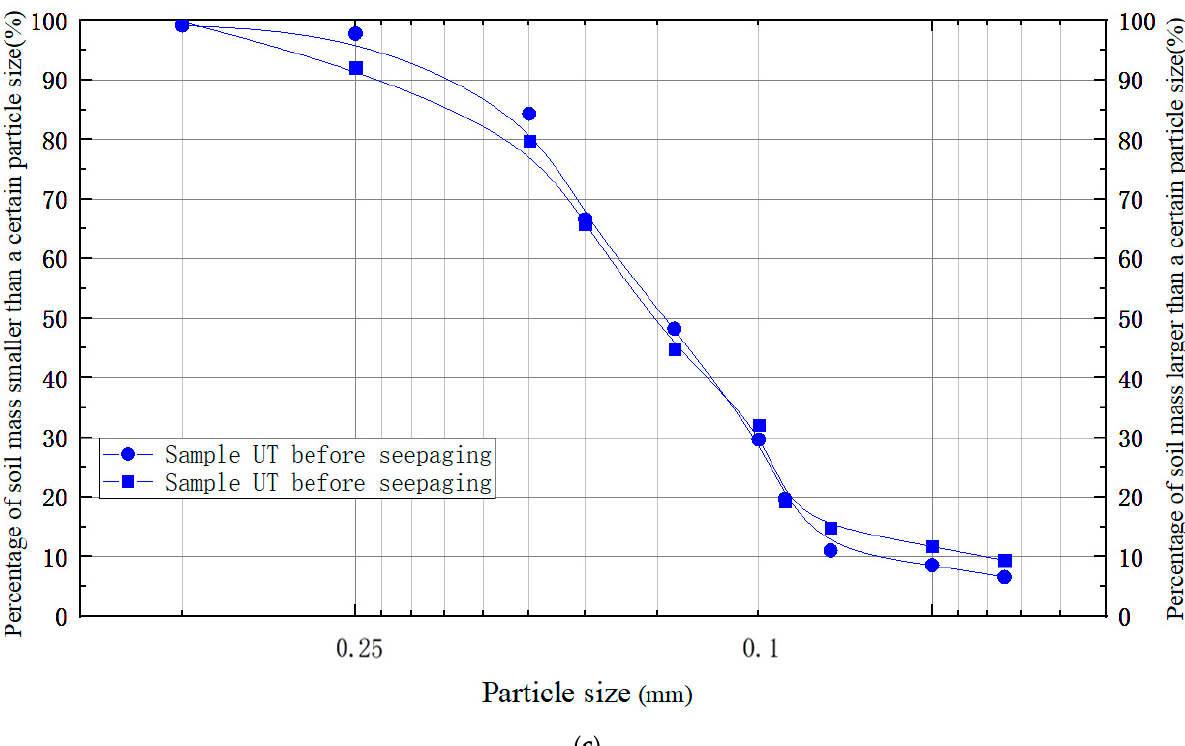
Figure 9. Comparison of particle-size distribution curves of tailings samples before and after internal erosion. ( a ) Sample DT. ( b ) Sample MT. ( c ) Sample UT.